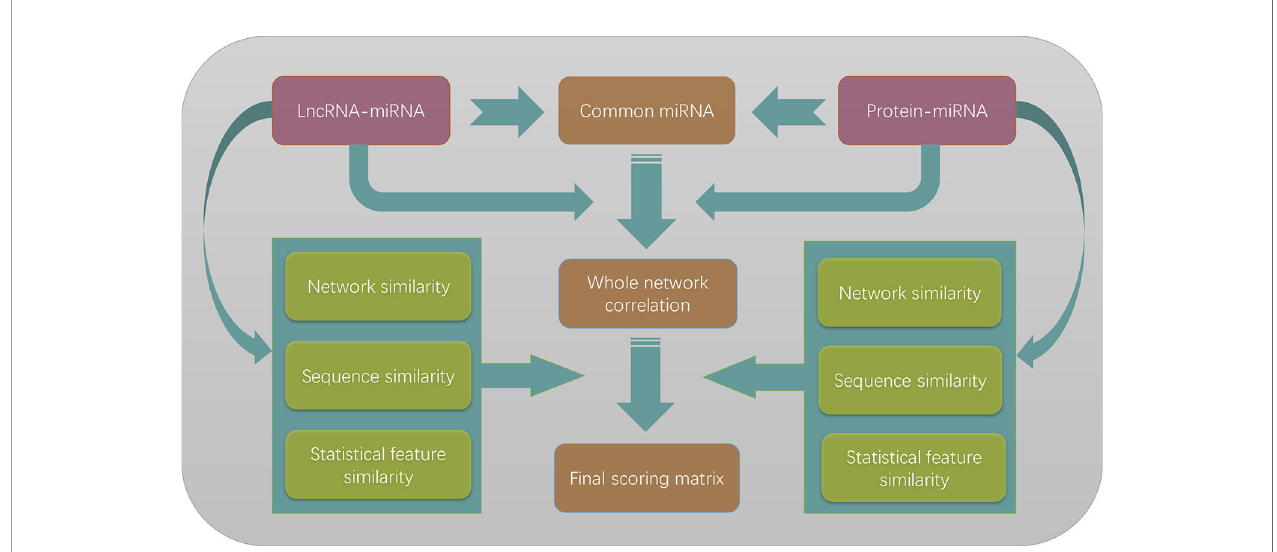
FIGURE 4 | The fl owchart of the entire work. The lncRNA – miRNA interactions and protein – miRNA interactions are merged to form a heterogeneous network model according to the commonly shared miRNAs in two different types of interactions. Three different similarity measures are combined with the whole network correlation matrix to form nine different scoring matrices. By optimizing the prediction performances, we fi nally choose to use network similarity measures for both lncRNAs and